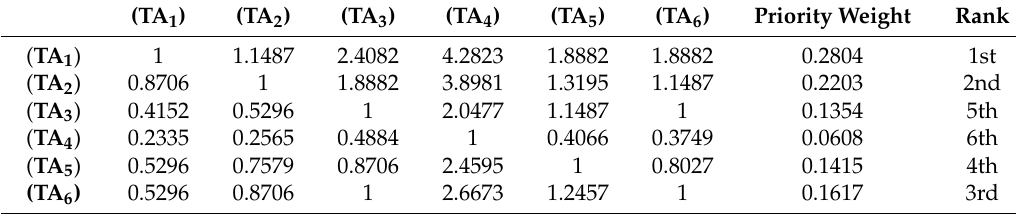
Table A6. Pair-wise comparison matrix of technical sub-factor.